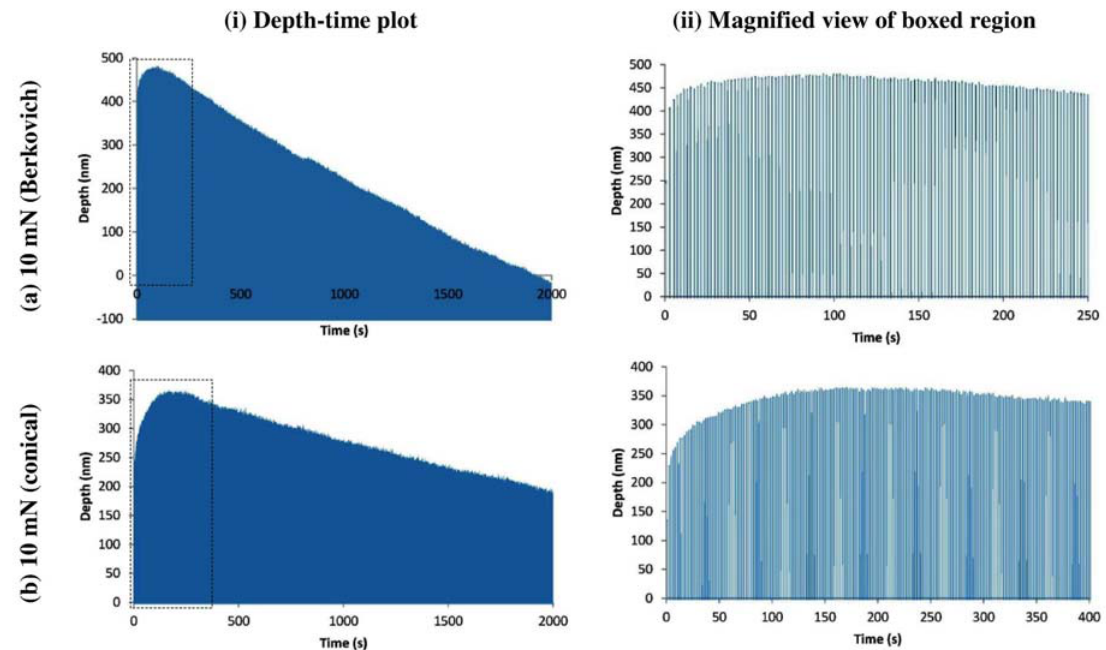
Figure 5. Nano-impact testing at 10 mN load: ( i ) Full record of impact depth-time measurement; ( ii ) corresponding magnified boxed-view of early stage of impacts.